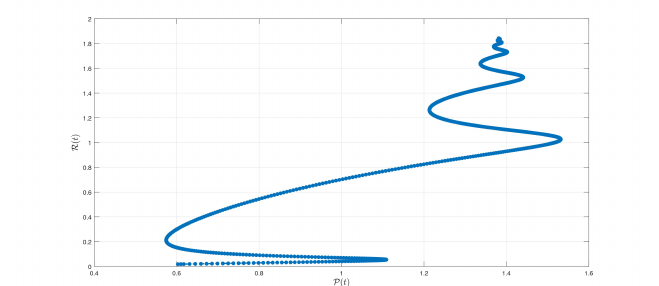
Figure 8. Behaviors of pair of sub-classes P ( t ) − O ( t ) .